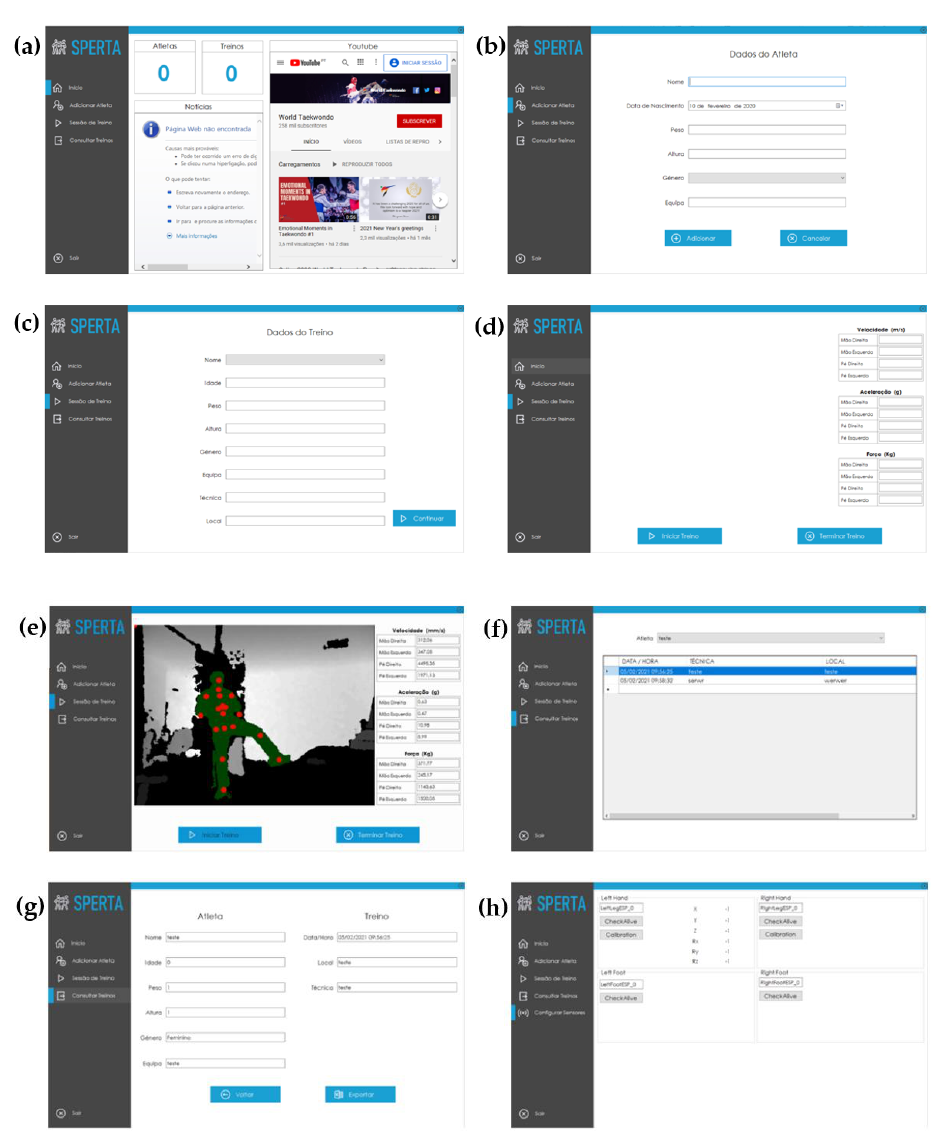
Figure 11. Software interfaces layout. Application starts screen (a), athlete data entry screen (b), training data entry screen to be performed (c), training start screen (d), training visualization screen and speed data, acceleration and strength (e), training consultation screen by athlete (f), athlete training data display screen (g) and motion sensors configuration screen (h).